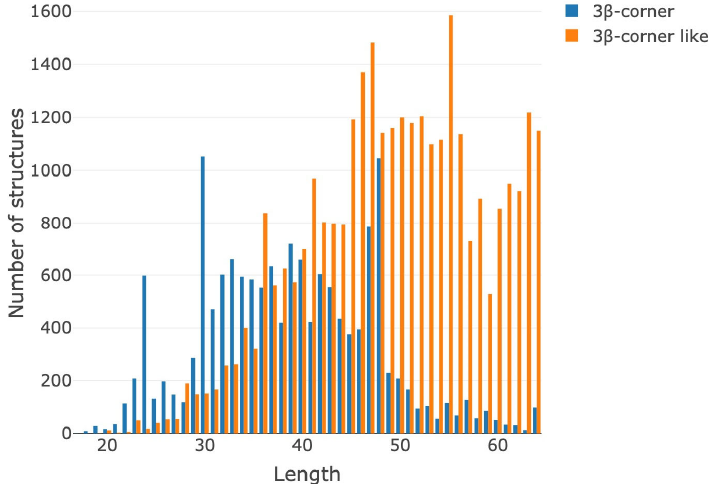
Figure 5. Histogram of the distribution of the number of found motifs depending on the lengths (number of amino acid residues) of the structures.